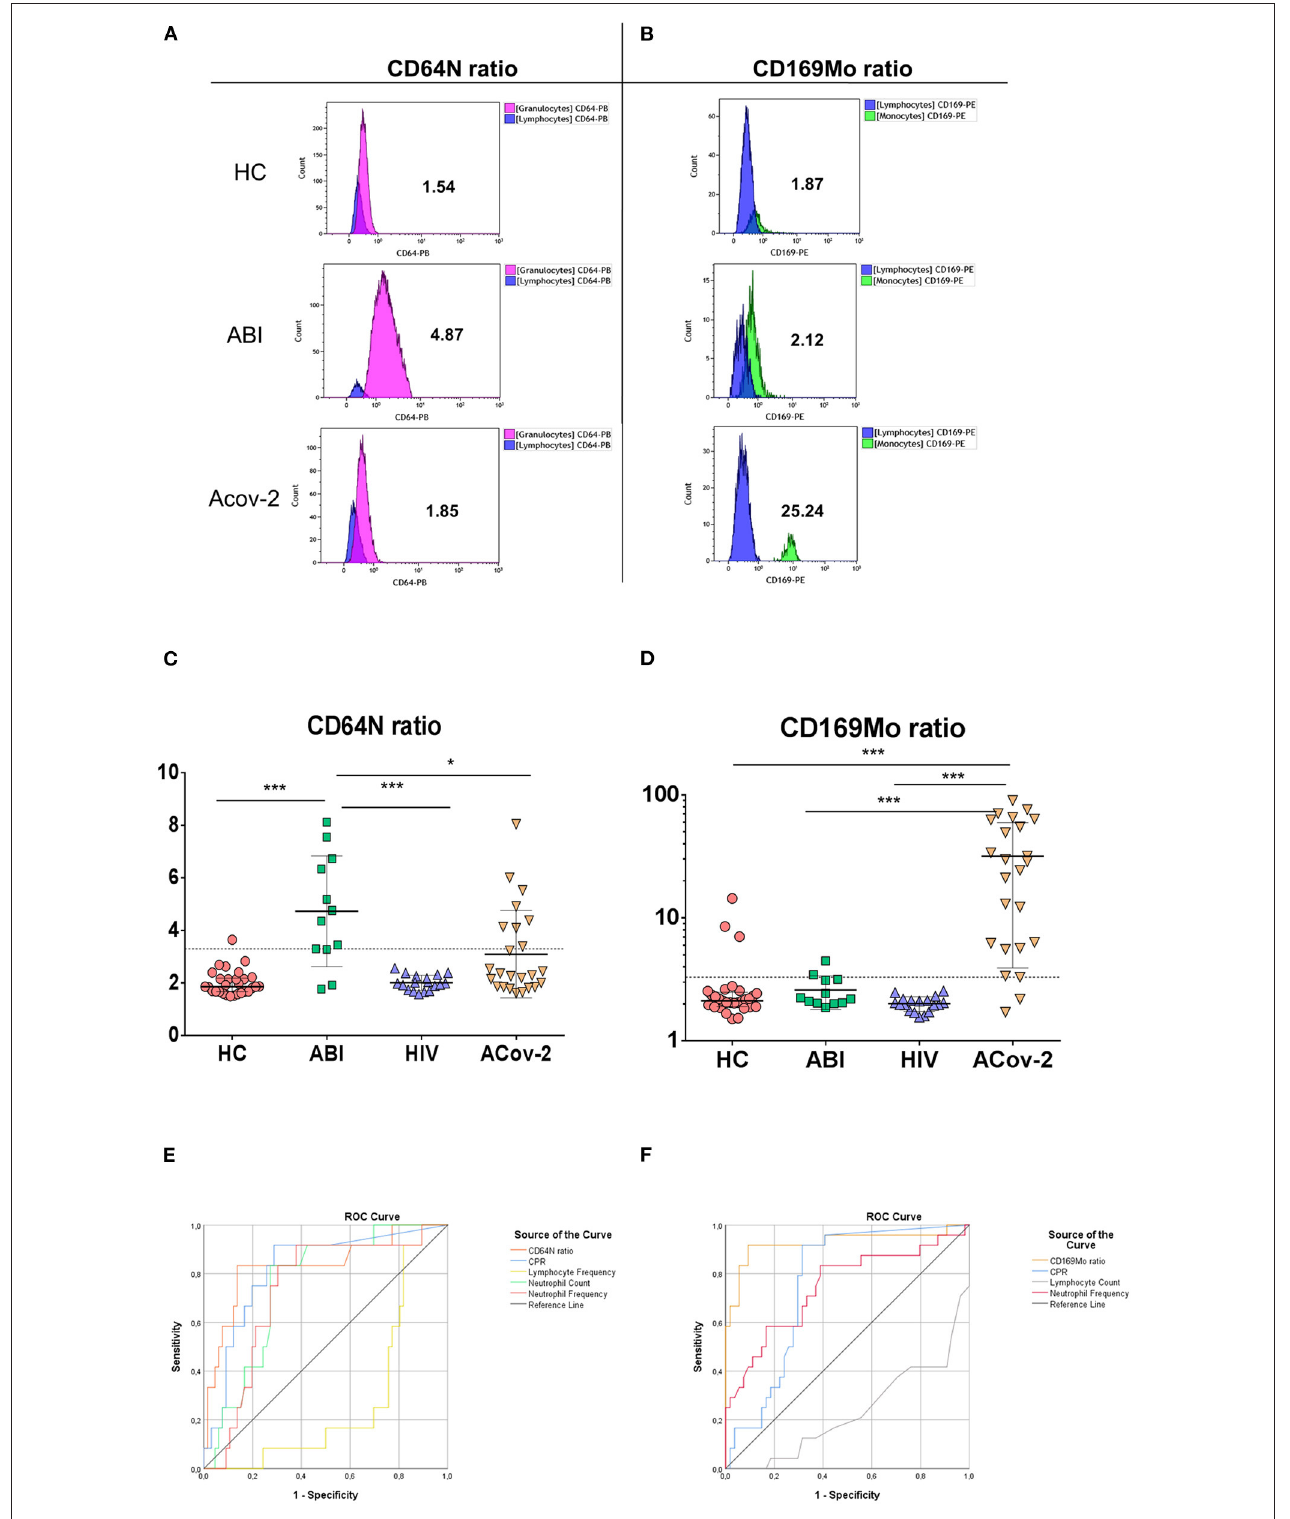
FIGURE 1 | Biomarkers of acute infection. Representative histograms of the median fluorescence intensity in neutrophil granulocytes (purple), lymphocytes (blue), and monocytes (green) of CD64 (A) and CD169 (B) expression in healthy control (HC), acute bacterial infection (ABI), and acute SARS-CoV-2 infection (ACov2) patient